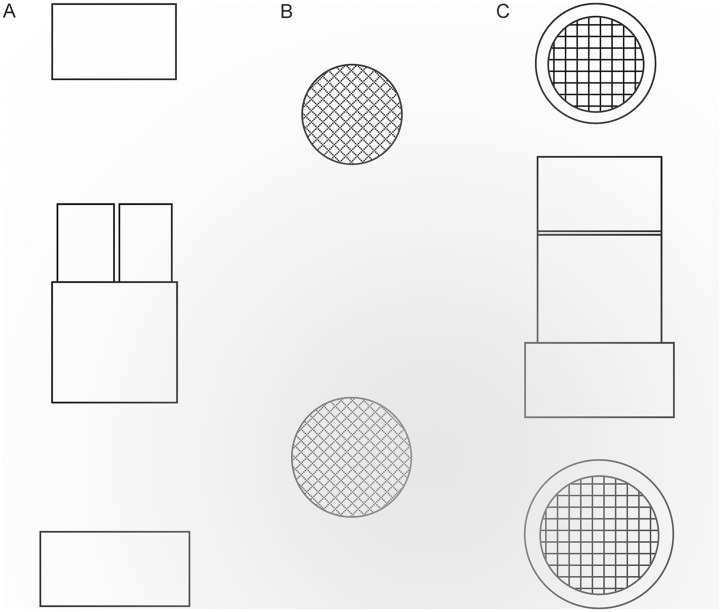
Design of the stainless steel capsule used to prepare Pseudapanteles dignus eggs and larvae for scanning electronic microscope (SEM) study.(A) Capsule in front view, opened. (B) Serigraphic- mesh pieces covering the internal sides of capsule openings in plan view. (C) Capsule in front view and plan view, closed.